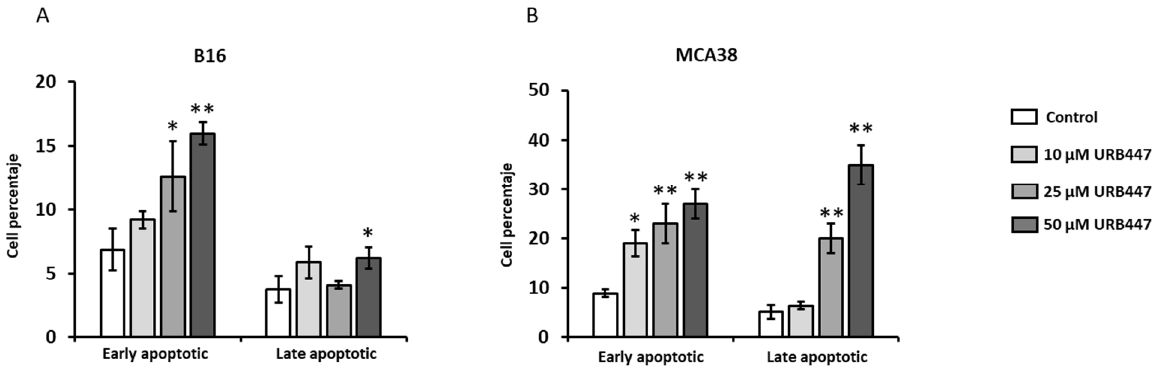
Figure 3. Apoptotic effect of URB447. Melanoma ( A ) and CRC cancer cells ( B ) were incubated in the presence of URB447 for 24 h. Flow cytometry was carried out to analyze early and late apoptotic cells. Images show representative FACS result ( n = 3). Differences were considered statistically significant for * p < 0.05, ** p < 0.01 using Student t test.